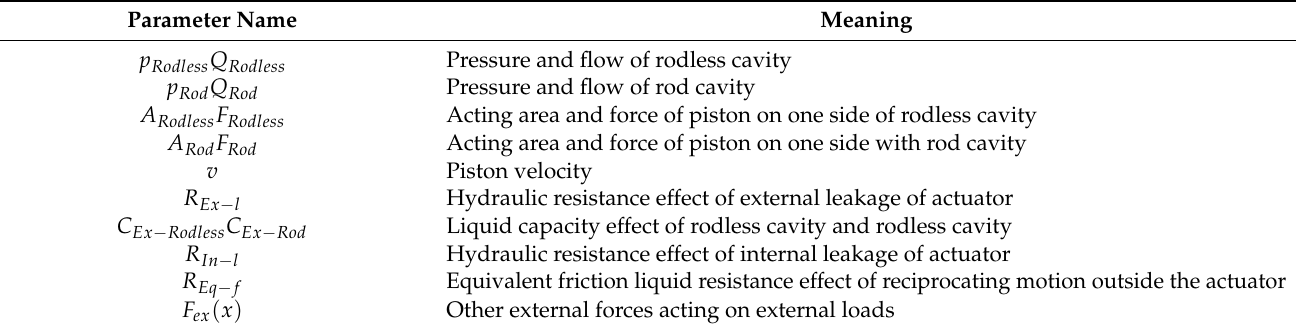
Figure 5. Actuator bond graph. Table 1. Parameters definition of actuators bond